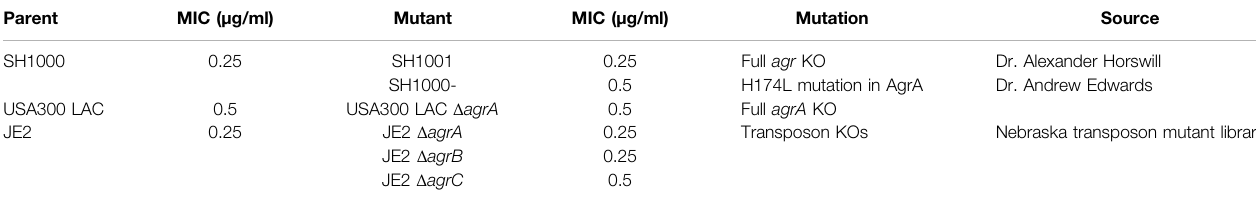
TABLE 1 | The three series of isogenic S. aureus strain pairs of agr wild-type and agr -defective used in this study and their daptomycin minimum inhibitory concentration (MIC). Parent MIC (µg/ml) Mutant MIC